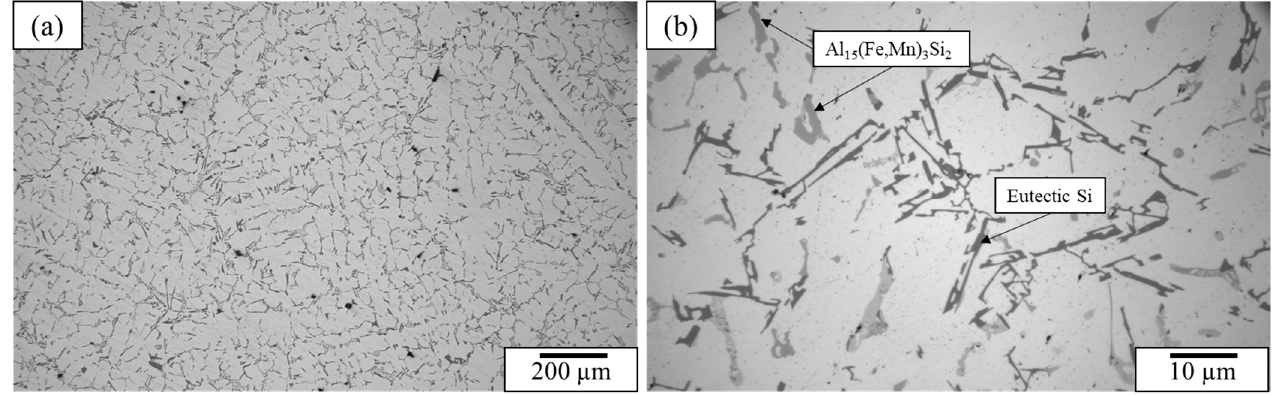
Figure 1. Optical micrographs of the A319 alloy captured at ( a ) 200× and ( b ) 1000× magnification. The SDAS decreased slightly with 0.05 wt.% GNP addition (A319 + 0.05 GNP + SS + UST) to 16.0 ± 0.8 µm compared to 19.8 ± 2.4 µm with the base A319 casting (Table 3). This